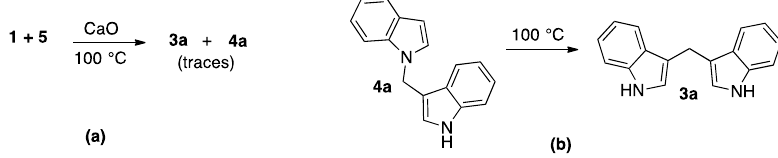
Table 1. Base effect on reaction between indole 1 and formaldehyde 2a at 100 °C.